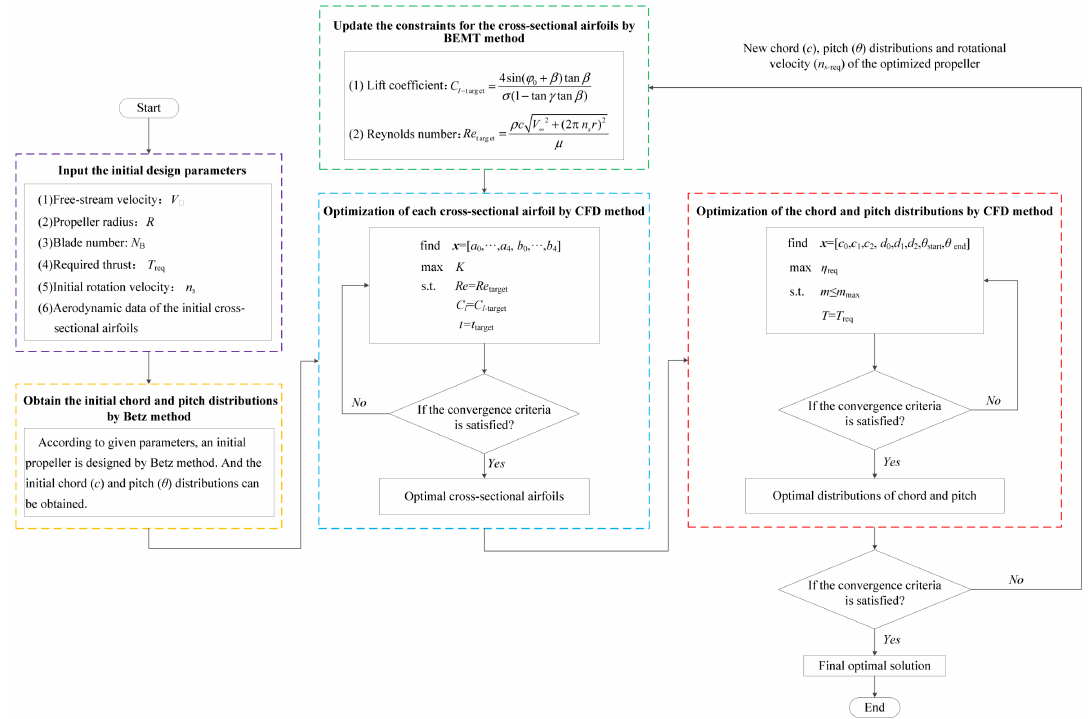
Figure 14. Flowchart of iterative optimization strategy for low Reynolds number